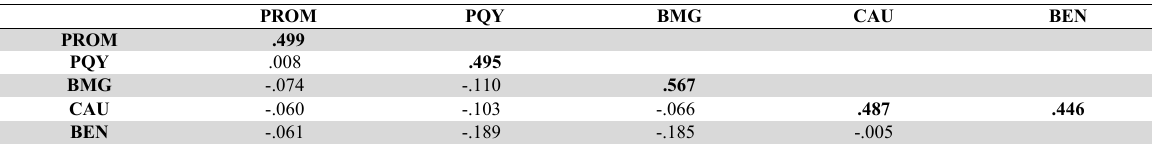
Heterotrait-Monotrait Ratio Scale